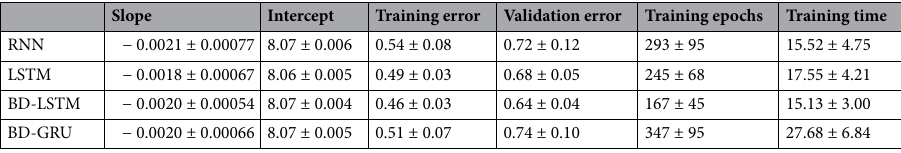
Table 2. Statistical comparison between different RNN